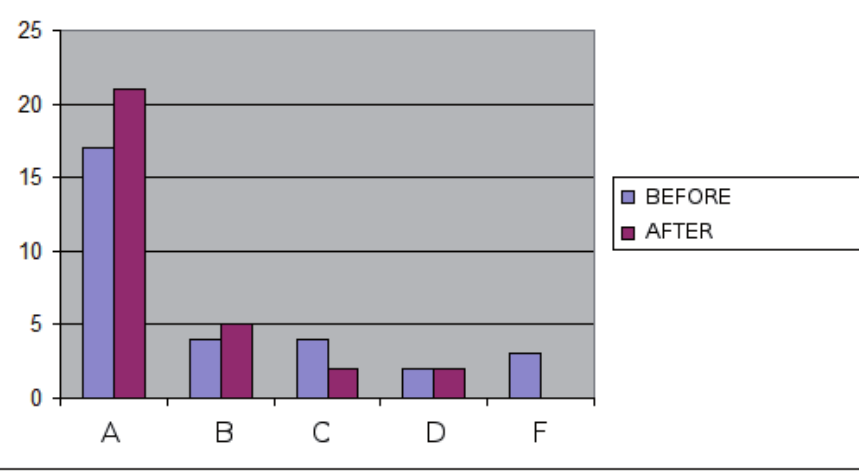
Fig. 4b. Programming grades in one fourth year class of the Electronic Engineering school Goša in Smederevska Palanka before and after the Project. Source: Own chart (Lajbenšperger, & Raji ć ,